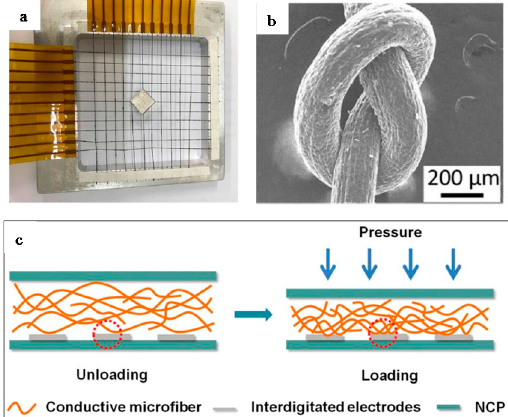
Figure 12. ( a ) Fabrication of the weight-to-strain sensor based on free-written net structure. Reprinted with permission from [108]; Copyright 2019 American Chemical Society. ( b ) SEM images of Ag NW / MWCNT / TPU fibers. Reprinted with permission from [108]; Copyright 2019 American Chemical Society. ( c ) Compressive deformation of the pressure sensor under the external pressure. Reprinted with permission from [110]; Copyright 2019 American Chemical Society.